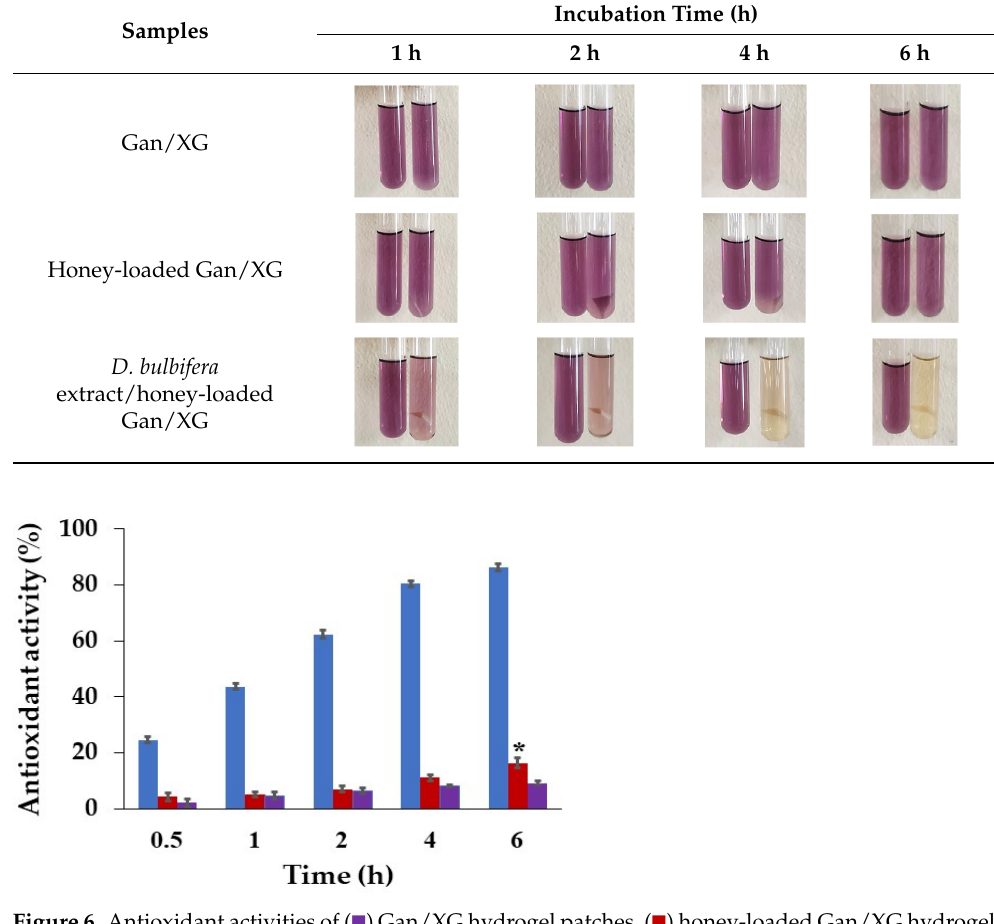
Table 6. Antioxidant activity of the hydrogel patches. The left tubes are the control, and the right tubes are the experimental groups.